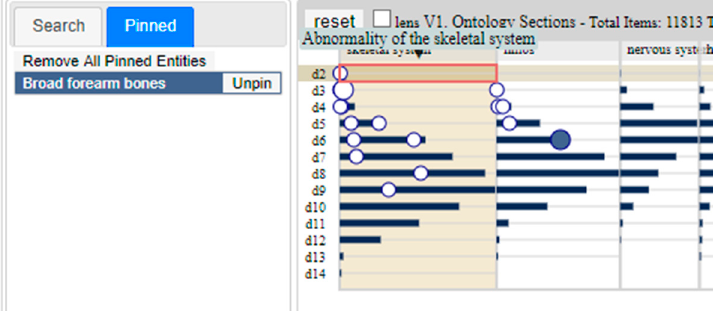
Figure 34. “Broad Forearm Bones” has been pinned, designating it as an important ontology en- tity, which is to be highlighted with its assigned color whenever it appears in a PRONTOVISE subview.